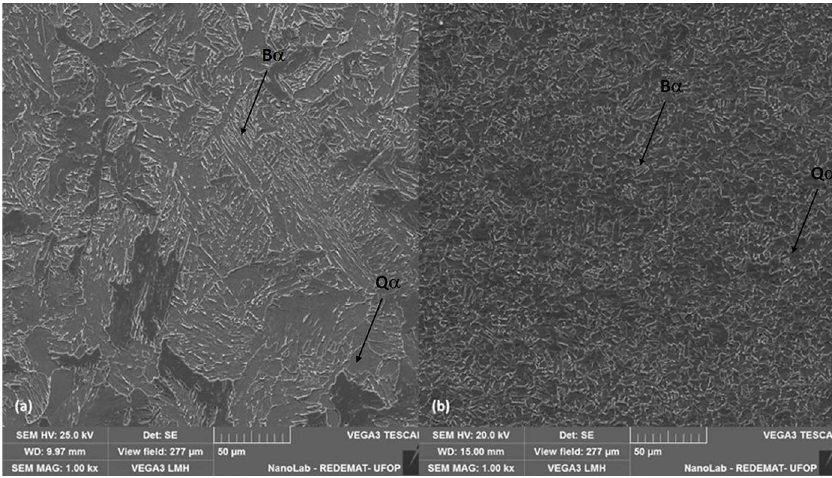
Figure 10. SEM micrographs of microstructures of (a) steel A and (b) steel B cooled with 50ºC/s - 1000X (Qα- quasi-polygonal ferrite and Bα- bainitic ferrite).